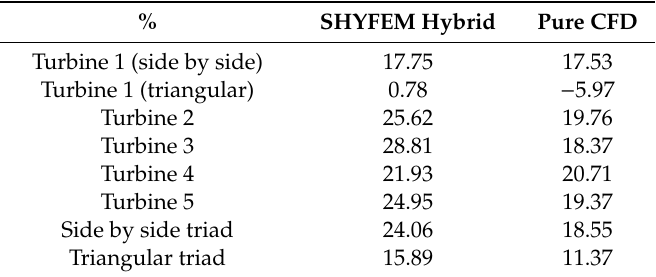
Table 4. Percentage changes in the performance of triads.